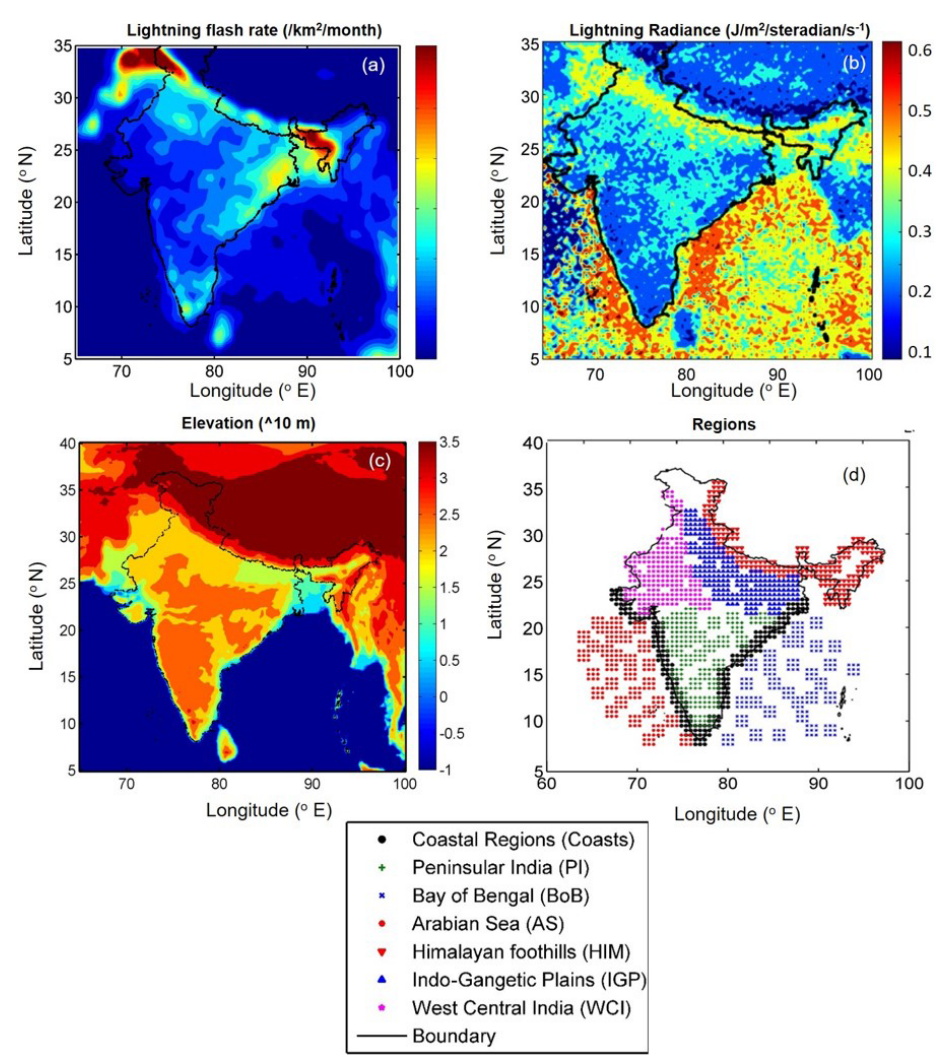
Figure 1. Climatological mean (a) lightning flash rate and (b) lightning radiance over India averaged from 1998 to 2014; (c) altitude above mean sea level on a base 10 logarithmic scale (seas denoted by − 1); and (d) the representation of the seven regions used in the